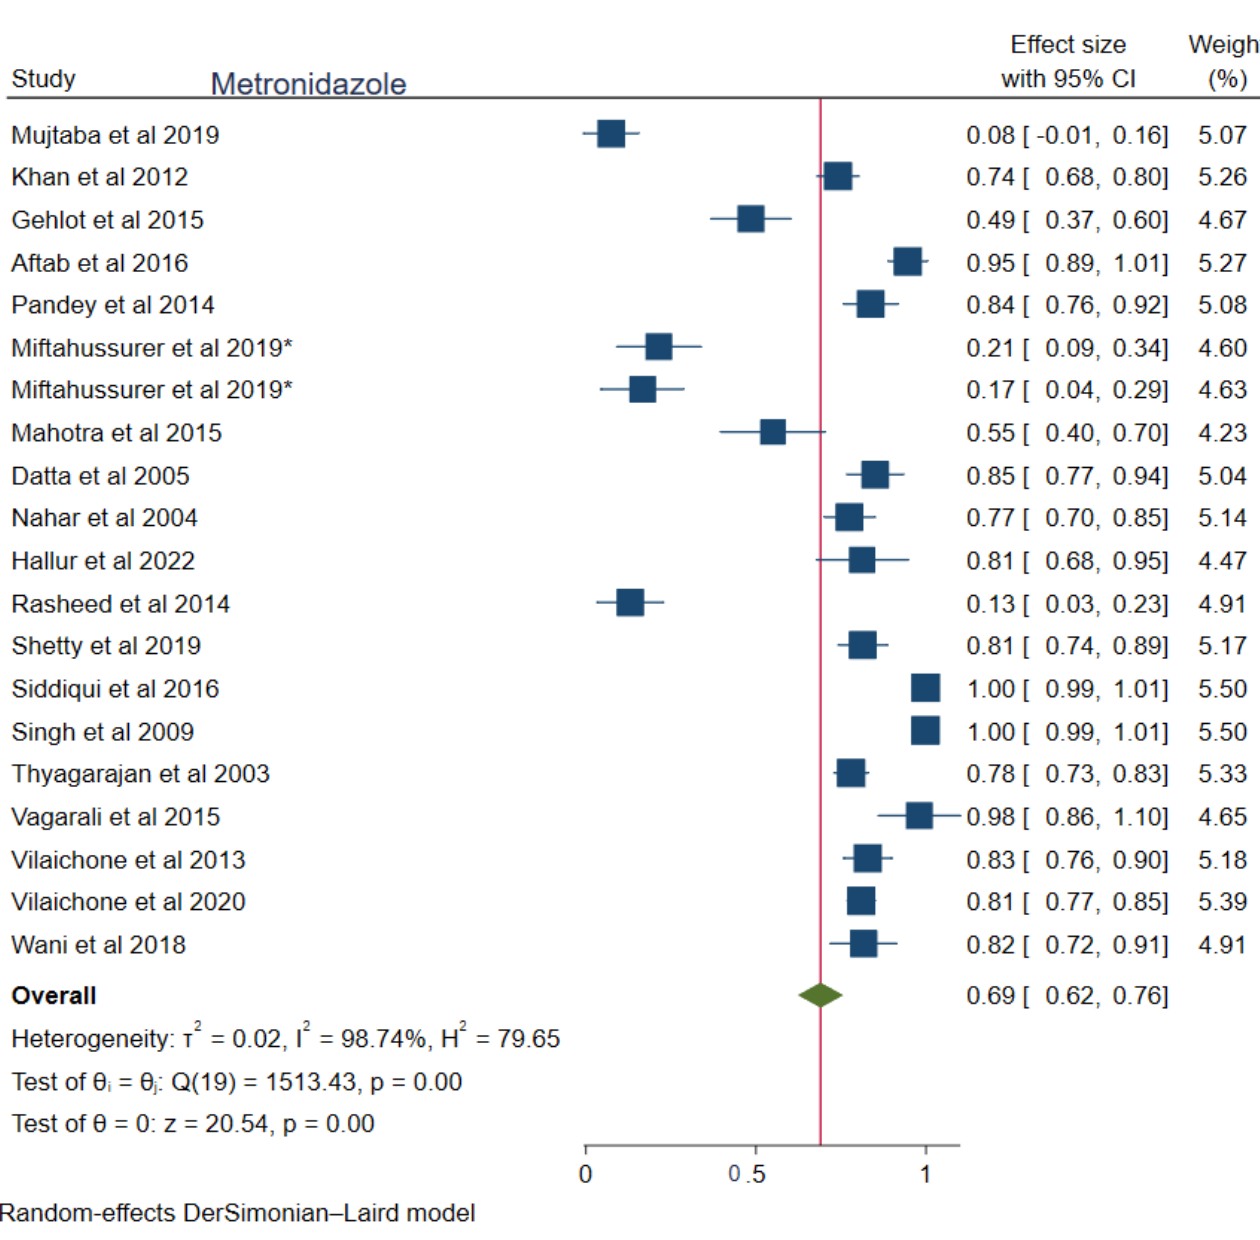
Figure 2. Forest Plot Showing Metronidazole Resistance. (*: the same study with data from two countries, Reference Studies: [14, 15, 21-27, 29-31, 33-39])